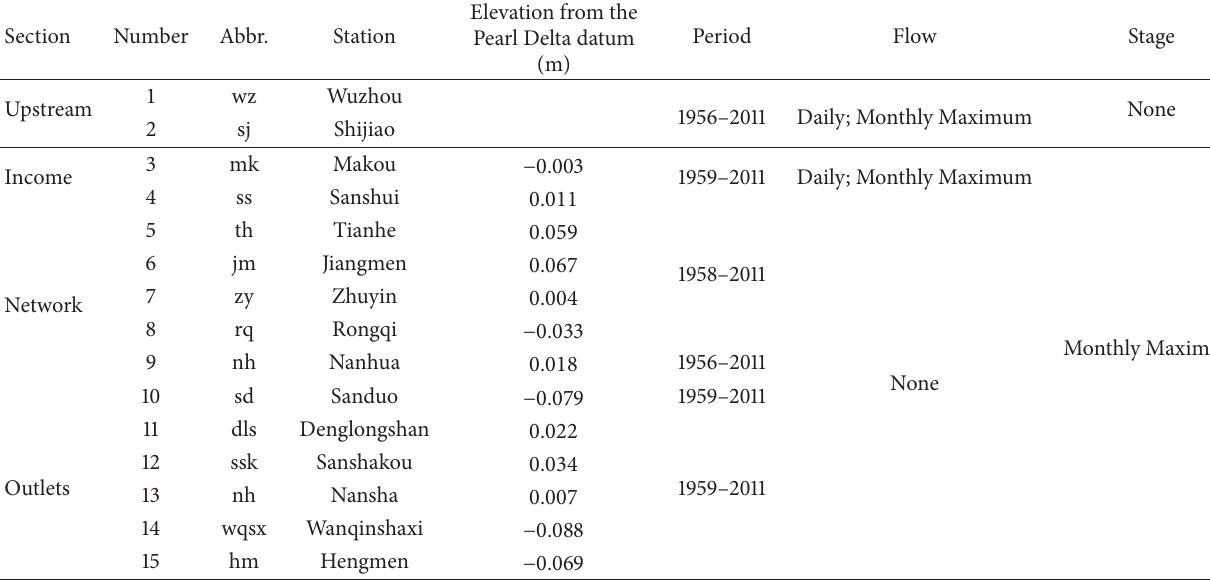
Table 2: Dataset of hydrological